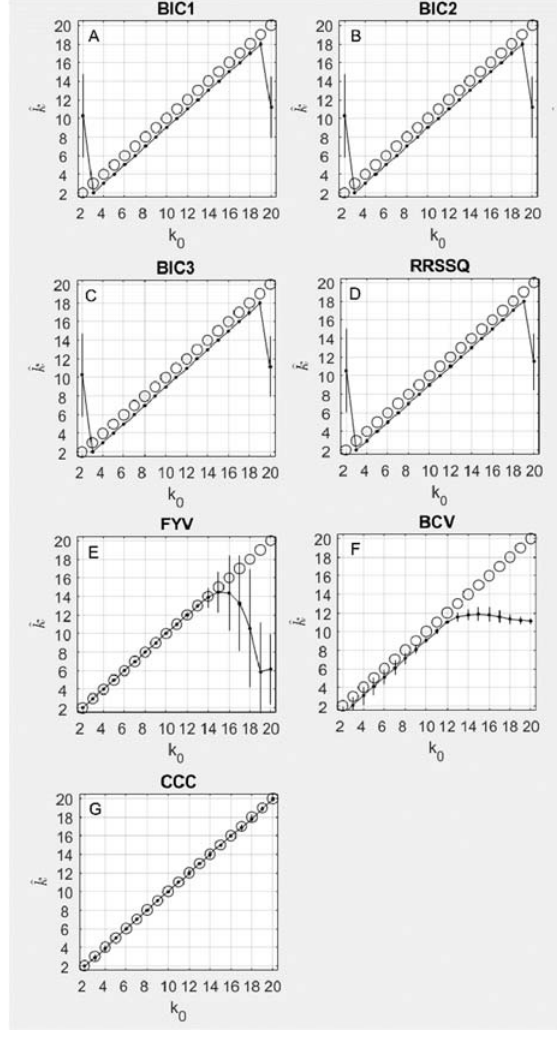
Figure 2. This figure plots the average results for seven iterative methods. The results are plotted as the true number of components simulated on each x axis and the number of components discovered by each algorithm on the y axis. Perfect accuracy should appear as a diagonal line, following the black circles. The mean result at each 𝑘 (cid:2868) is shown as a black dot and its standard deviation is shown as a black vertical line. Panes include results for ( A – C ) three Bayesian information criterion (BIC) methods, ( D ) Shao’s relative root of sum of square differences method (RRSSQ), ( E ) Fogel and Young’s volume-based method, ( F ) Owen and Perry’s bi-cross-validation method (BCV), and ( G ) Brunet’s cophenetic correlation coefficient method (CCC).